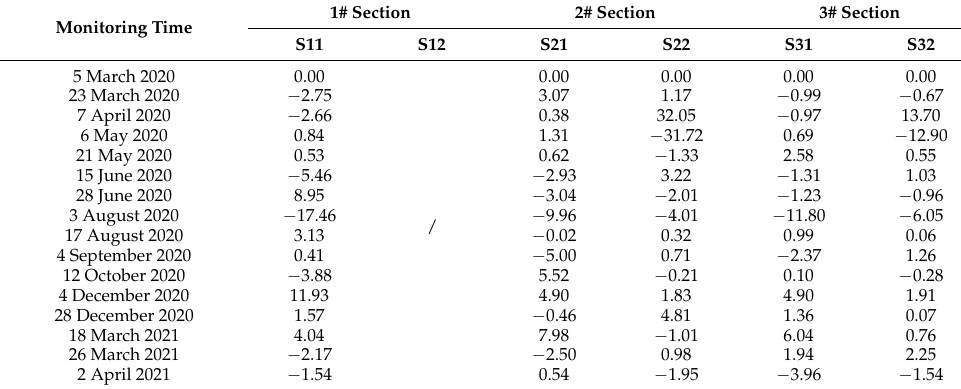
Figure 9. 3 # section horizontal displacement duration curve (upstream is − , downstream is +). Table 2. Horizontal displacement.